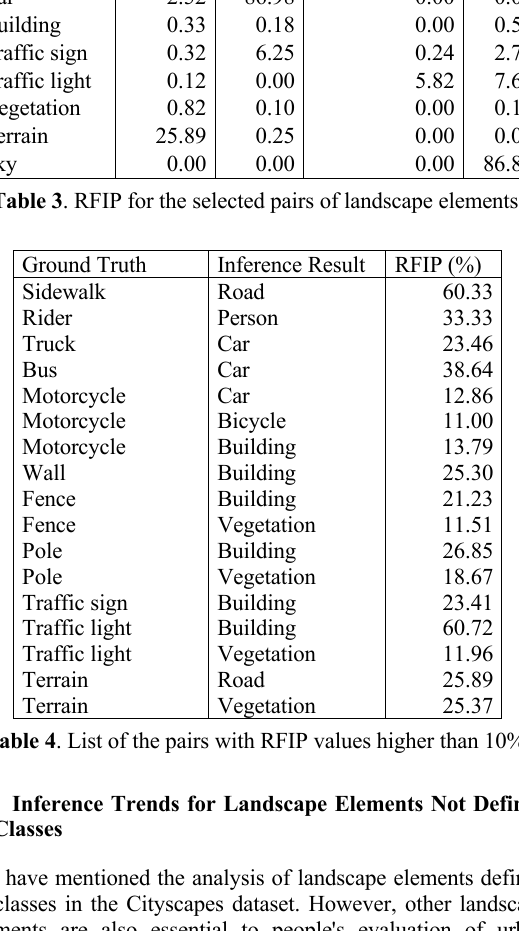
divided based on the characteristics of the fixed physical configuration of the street space and characteristics of the mobile elements that appear temporarily in that space (Table